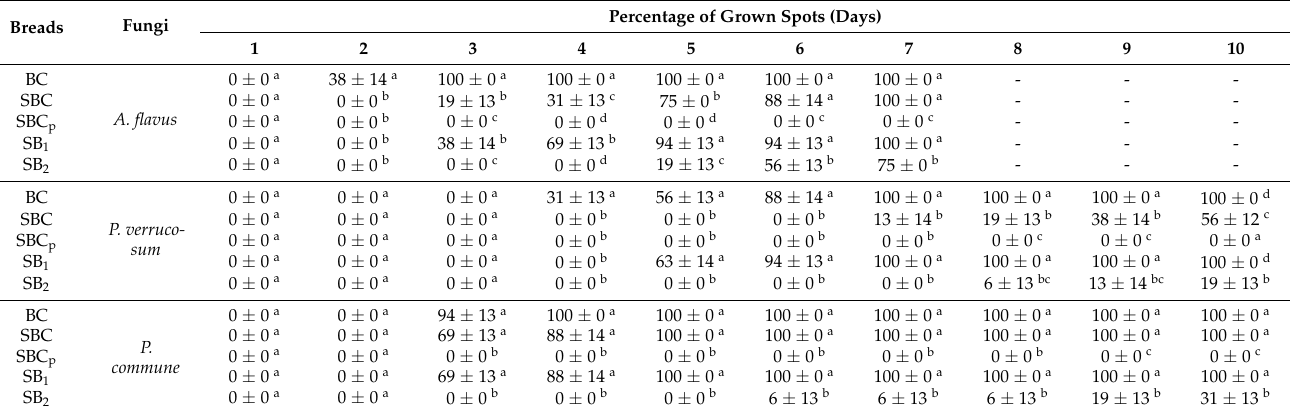
Table 5. Results of the study of the shelf life of the different bread samples contaminated with spores of A. flavus , P. verrucosum , and P. commune. Each bread was cut into four slices with four contamination